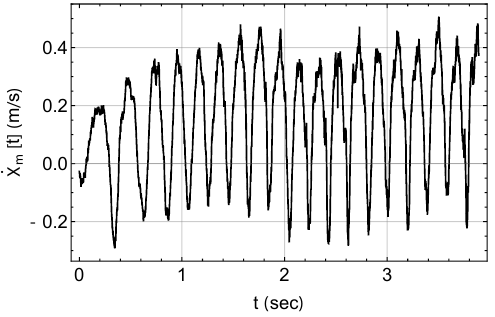
Figure 18. Experimental Horizontal Velocity of Tapping